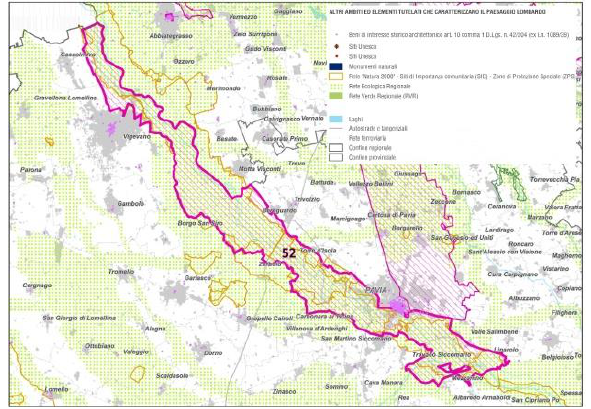
Figure 5. Aggregation 52 of bonded areas and sites regarding Ticino River Valley (in pink) and its connection with supra- national protections, such as Natura 2000 sites, Unesco sites and to other protected areas at regional level (Regional Parks and Reserves, eco-museums, natural monuments, geosites, Regional Ecological Network, Regional Green Network,